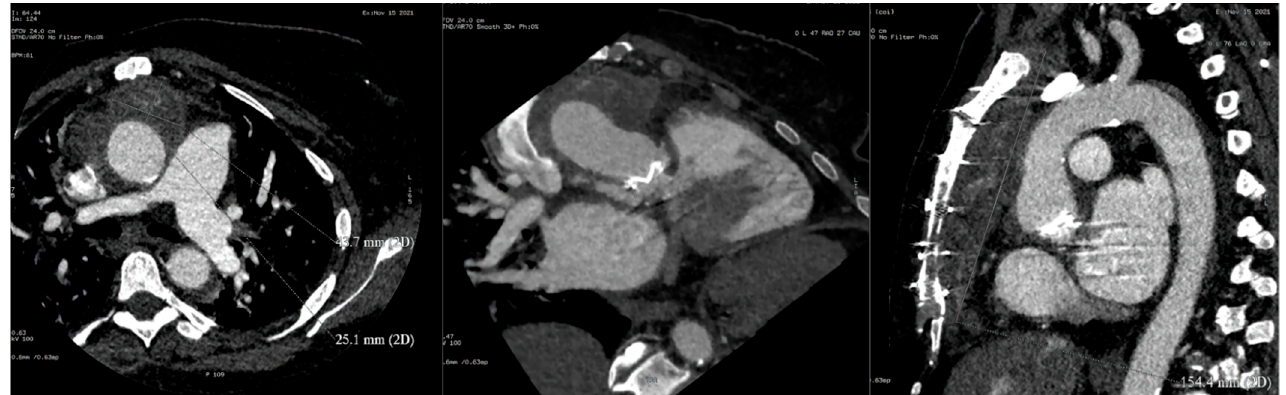
Figure 5. Cardiac CT showing periaortic collection and pseudoaneurysm in the ascending aorta.